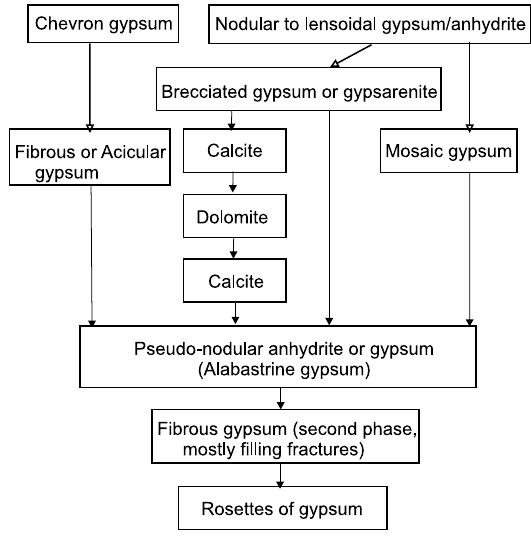
Fig. 5 – The several phases of evaporites recognized in the Codó Formation, with indication of their